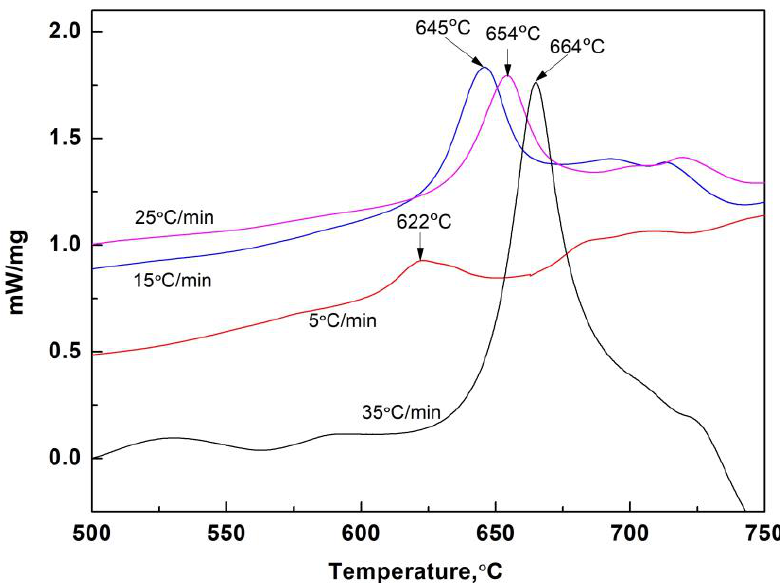
Figure 8. DSC curves of quenched glassy powder of No. 1 slag with different heating rates.